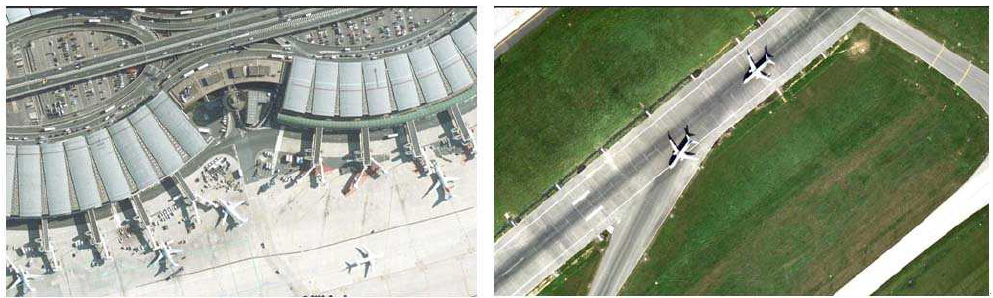
Figure 10. Airplane objects in high-resolution remote sensing